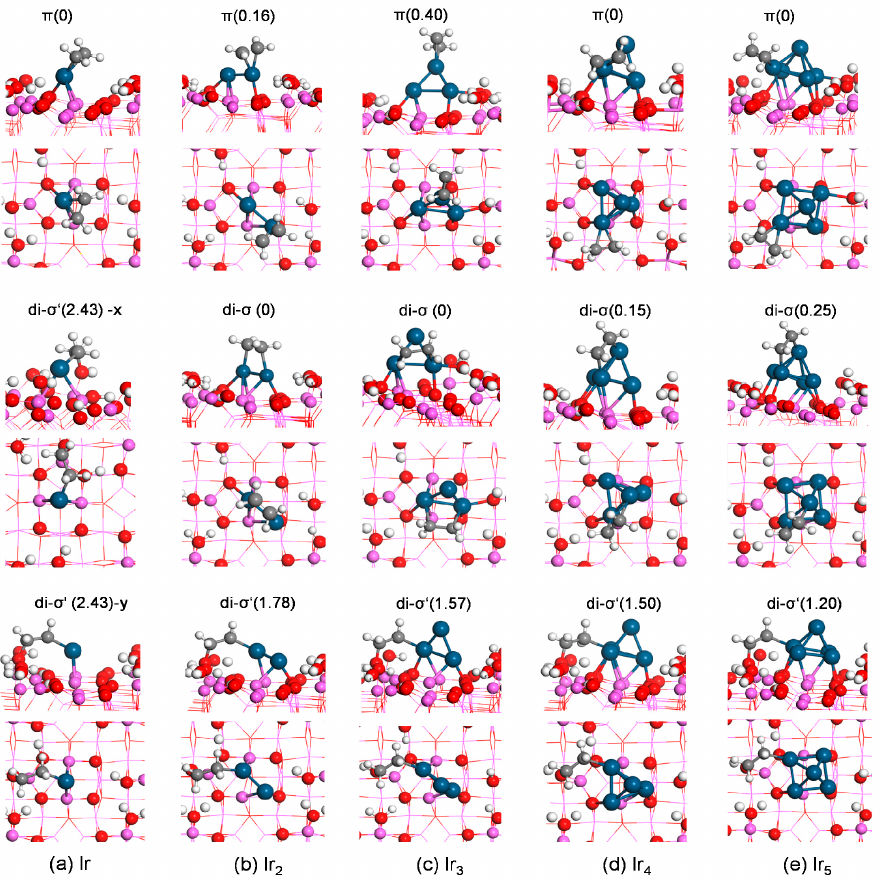
Figure 4. Side view (top) and top view (bottom) of most stable structure for each ethylene-binding mode on γ -Al 2 O 3 (110)-supported Ir n (n = 1–5). The energy difference (eV) with respect to the most stable configuration (energy set to 0) is labeled at the top of the structure. For the di- σ ' mode at the interface on supported Ir monomer, x and y are the different views of the same structure along two directions. The largest spheres are Ir, and the other color/label scheme is identical to Figure 1.